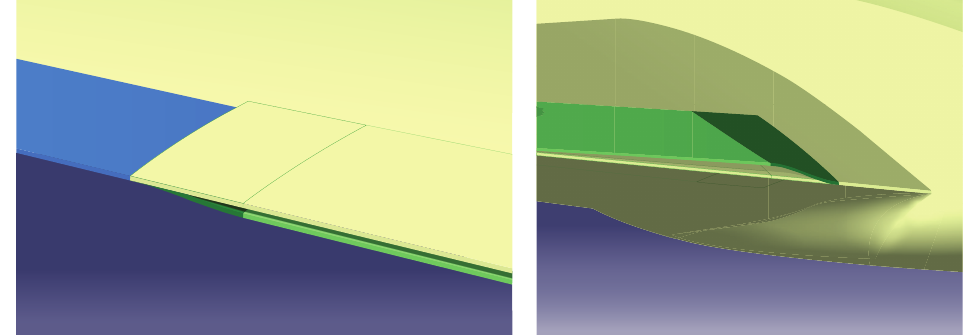
Figure 17: Parametric CAD model of the 28 % chordwise morphing trailing edge for high speed condition under skin structural constraint.